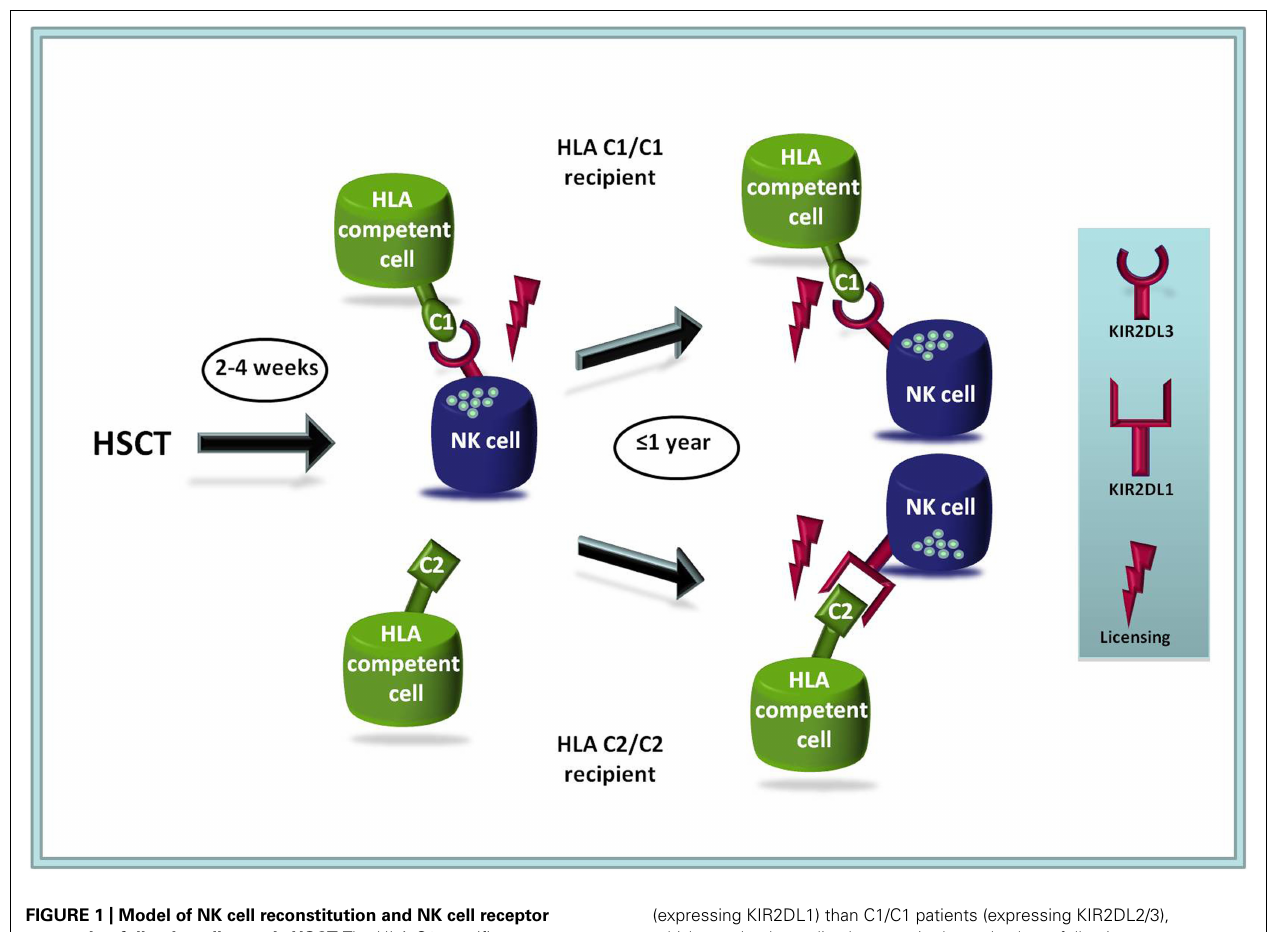
FIGURE 1 | Model of NK cell reconstitution and NK cell receptor expression following allogeneic HSCT. The HLA-C1-specific KIR2DL2/3 receptor is expressed at earlier time points on reconstituting NK cells than the HLA-C2-specific KIR2DL1 (Shilling etal., 2003; Nguyen etal., 2005; Fischer etal., 2007).Thus, in the clinical setting C2/C2 recipients possess a lower frequency of functionally competent NK cells